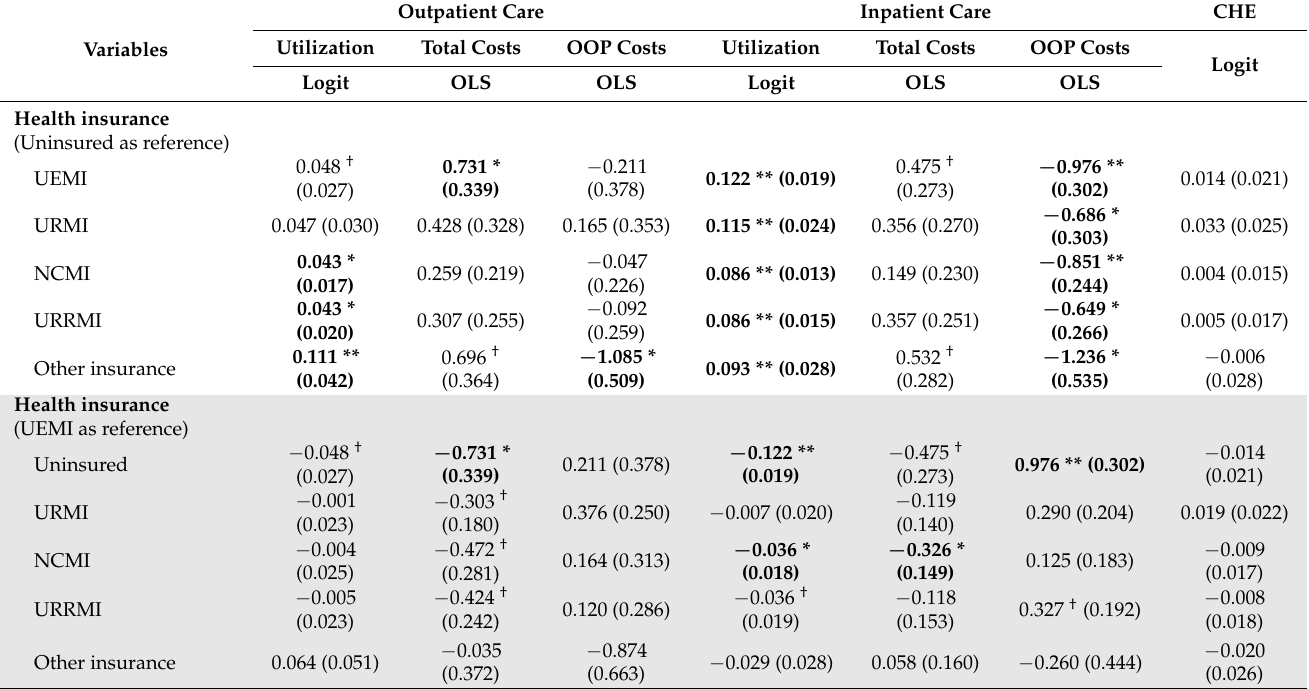
Table 4. Two-part model for health utilization and costs (inpatient and outpatient) and logistic regression for